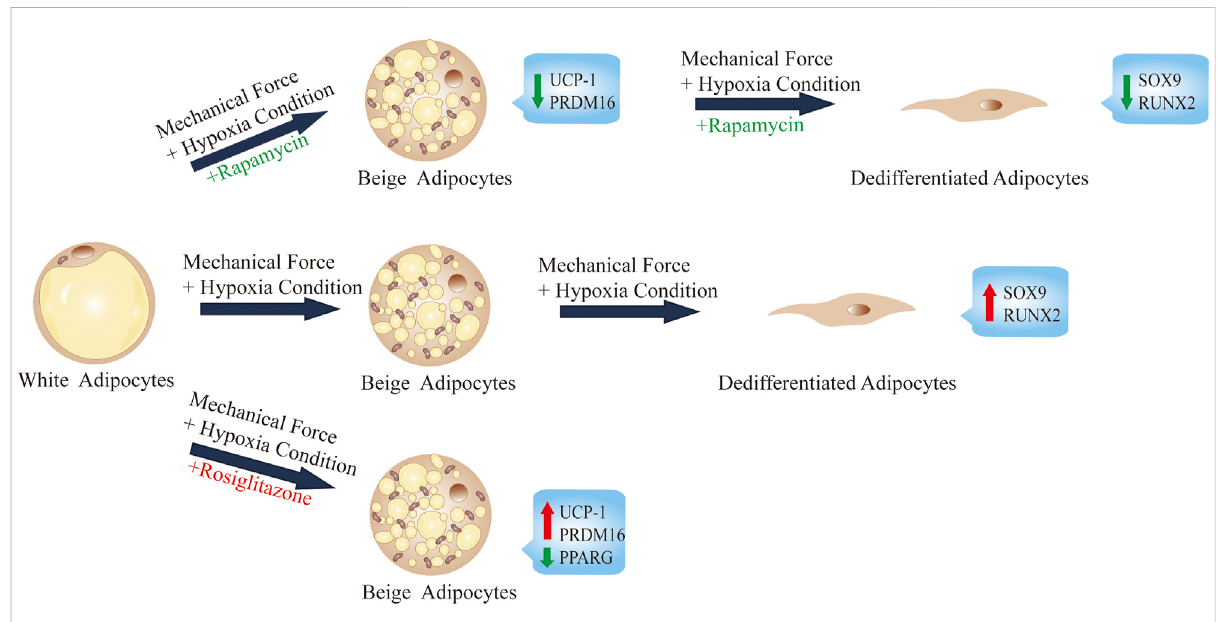
FIGURE 6 Summary and proposed model of ceiling culture of human mature white adipocytes with a browning